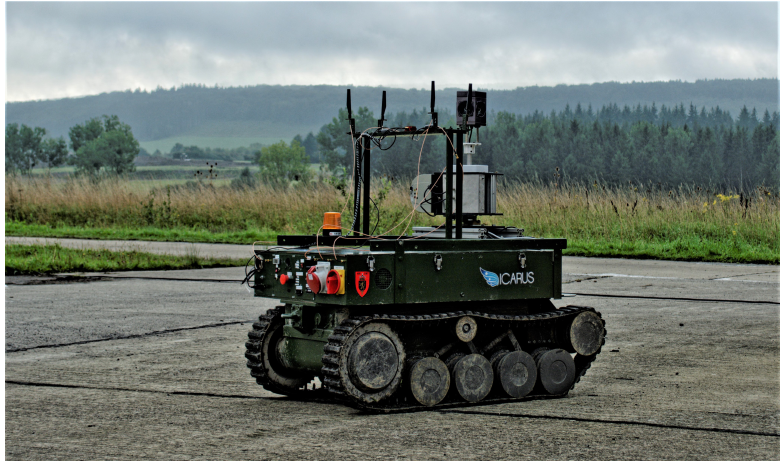
Figure 13. RMA tEODor UGV with the 3D mapping